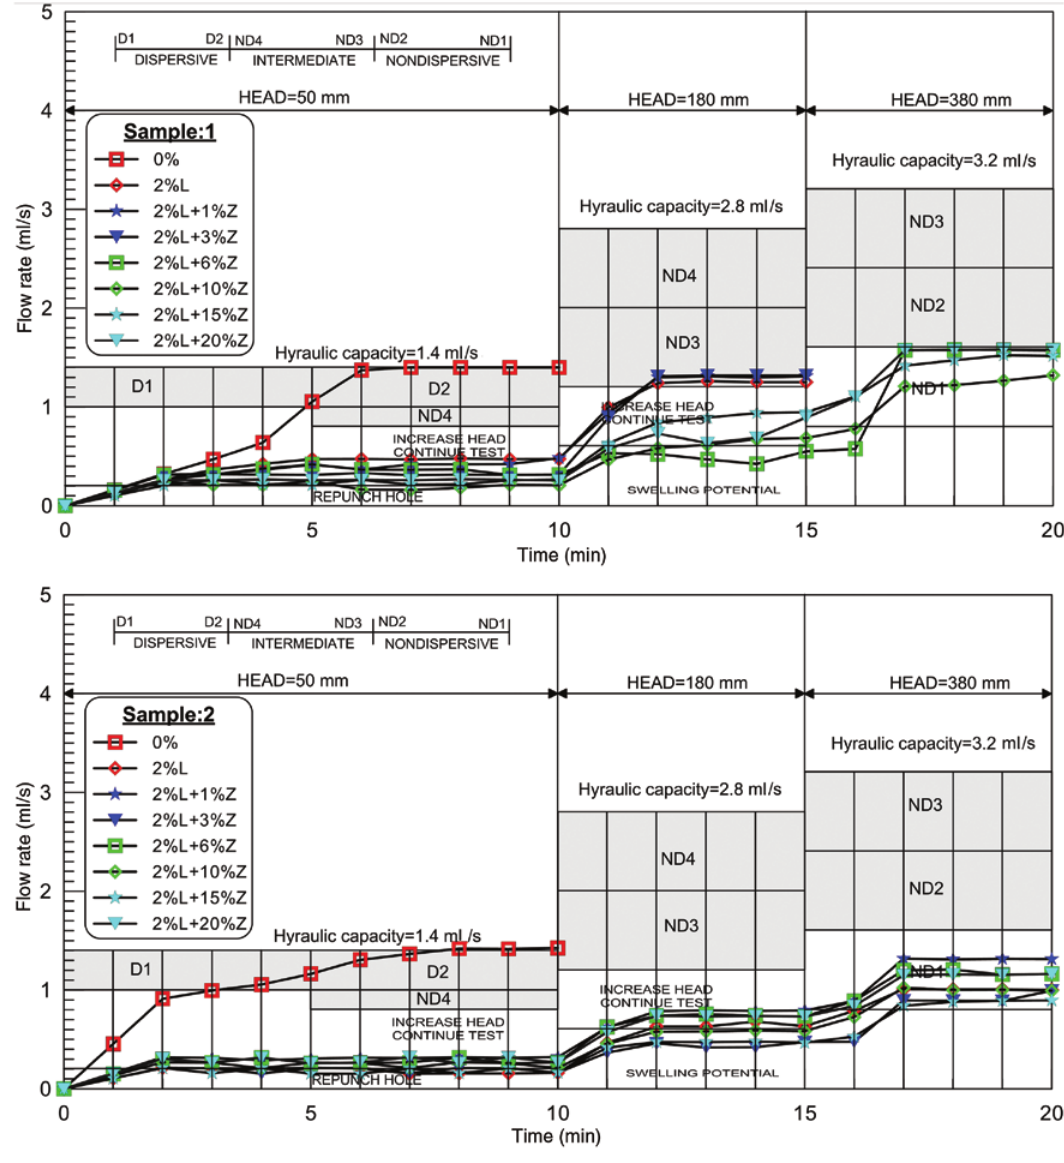
Figure 1 : Pinhole test results of the soil samples mixed with different additive contents.